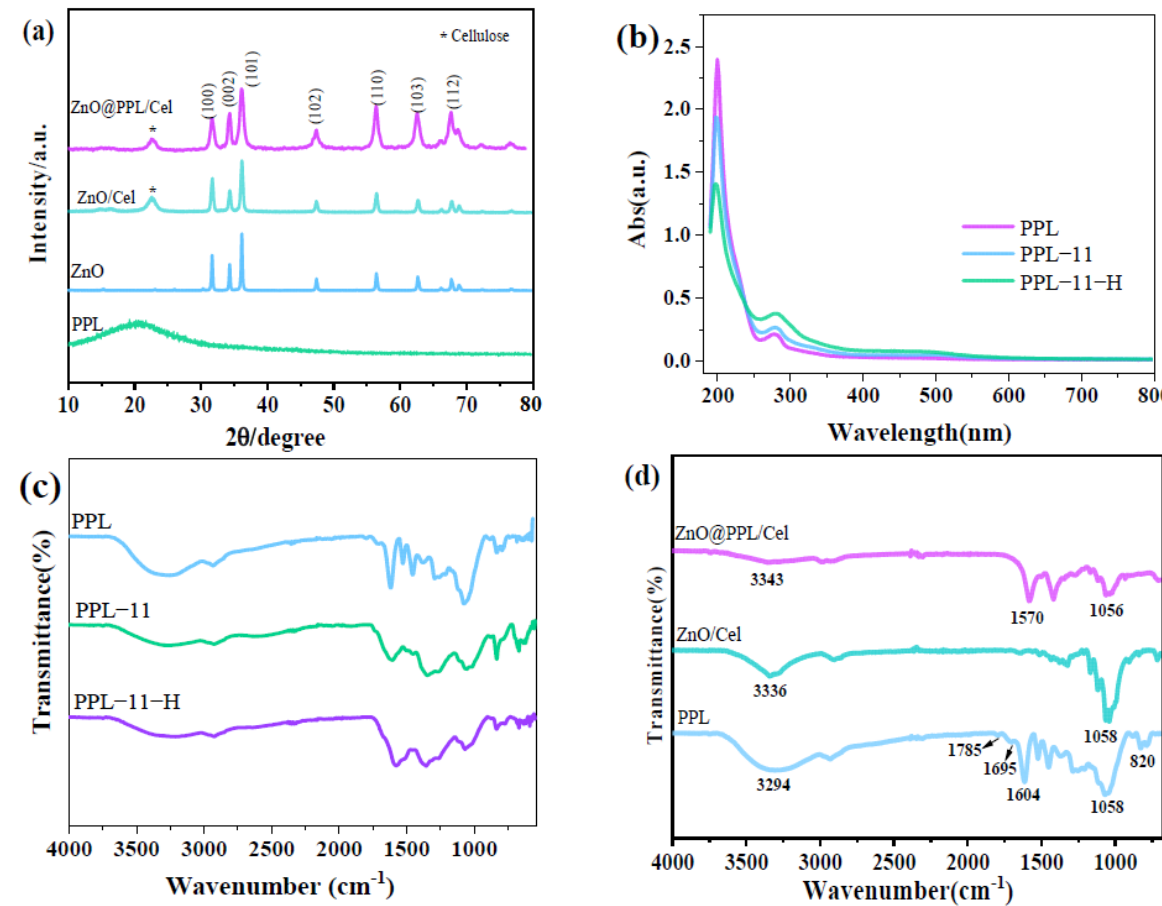
Figure 1. ( a ) XRD patterns, ( b ) UV spectra of PPL, and ( c , d ) FT-IR spectra of PPL and treated PPL as well as ZnO/Cel and ZnO@PPL/Cel ( * is diffraction peak of cellulose).